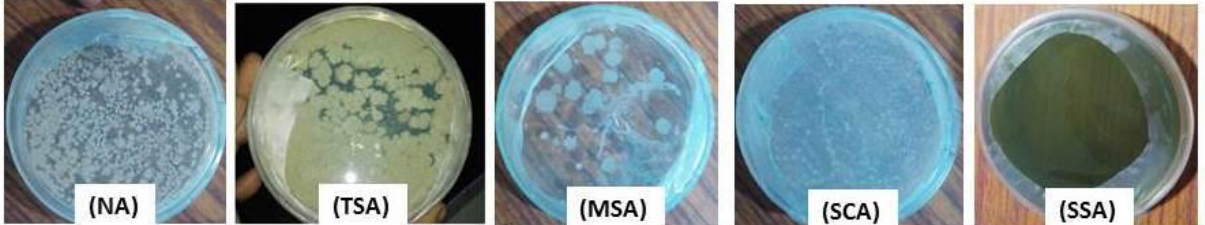
Fig. 2. Nutrient Agar (NA), Tryptic Soy Agar (TSA), Mannitol salt agar (MSA), Simmons' citrate agar (SCA) and Salmonella Shigella Agar (SSA) plates